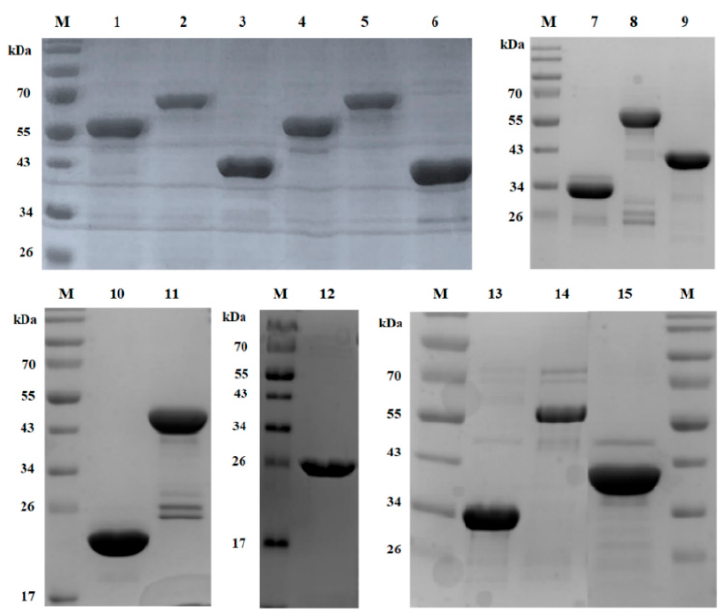
Figure 2. SDS-polyacrylamide gel electrophoresis analysis of LysSA12, LysSA97, and their derived proteins. Proteins were purified by nickel-nitrilotriacetic acid affinity chromatography and analyzed using 12% SDS-polyacrylamide gel electrophoresis. Lane M, protein ladder; lane 1, EGFP_LSA12AMI; lane 2, EGFP_LSA12AMICBD; lane 3, EGFP_LSA12CBD; lane 4, EGFP_LSA97AMI; lane 5, EGFP_LS A97AMICBD; lane 6, EGFP_LSA97CBD; lane 7, LSA12 CHAPCBD; lane 8, LysSA12; lane 9, LSA12AM ICBD; lane 10, LSA12CHAP; lane 11, LSA12CHAPAMI; lane 12, LSA12AMI; lane 13, LSA97CHAPCBD;